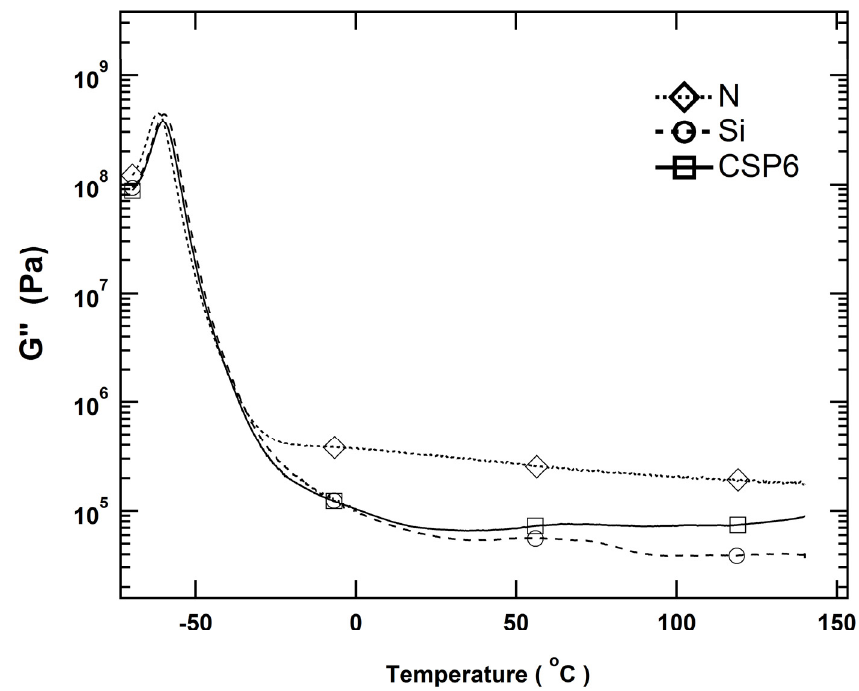
Figure 10. Loss moduli for silica reinforced rubbers and protein/CaCO 3 reinforced rubber, where N is silica without coupling agent and Si is silica coated with silane coupling agent.